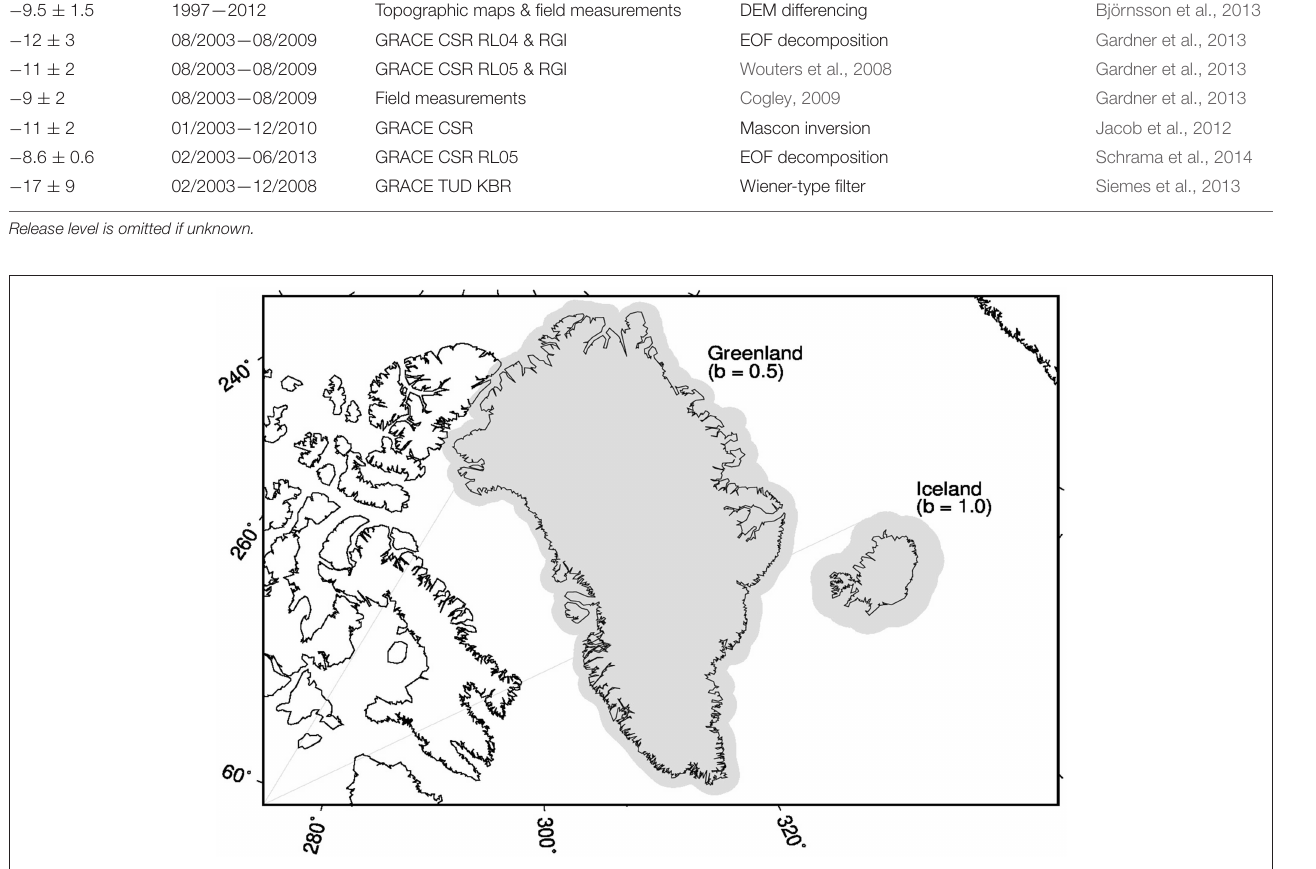
GRACE data (Horwath and Dietrich, 2006). For a related conversation and case study, see Schmidt et al. (2007) and Horwath and Dietrich (2009),